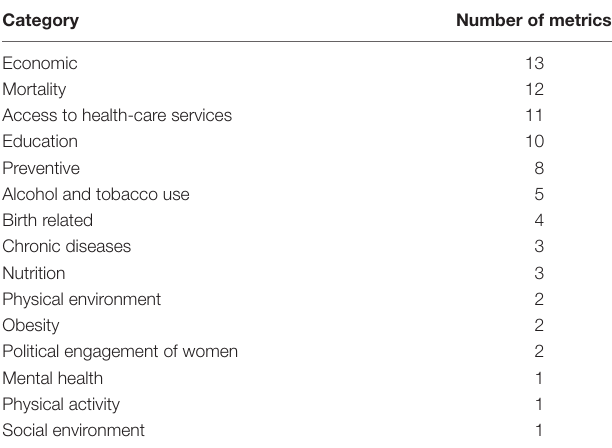
TABLe 9 | Distribution of outcome metrics among selected major programs and reports.